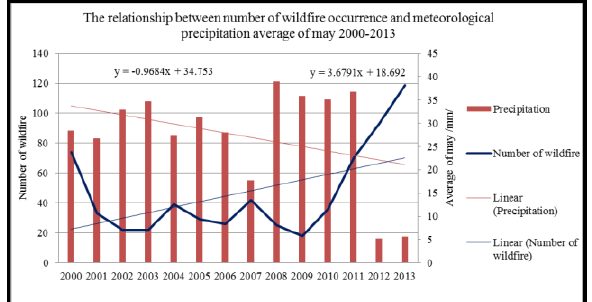
Figure 6. Trend of relationship between wildfire and climate